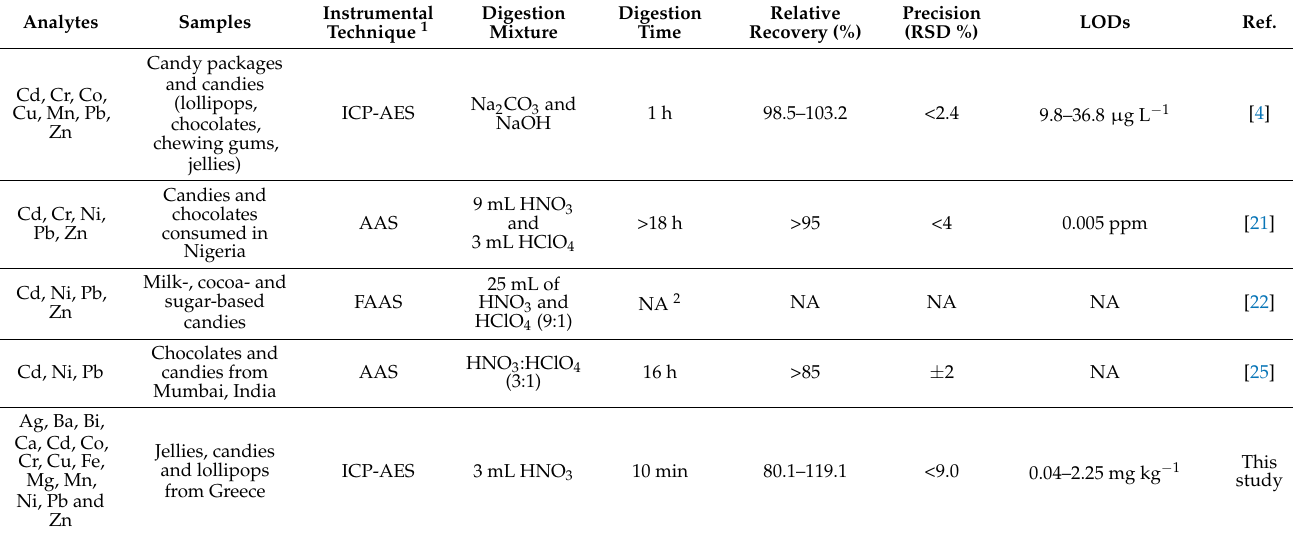
Table 8. Comparison of the herein developed procedure with other